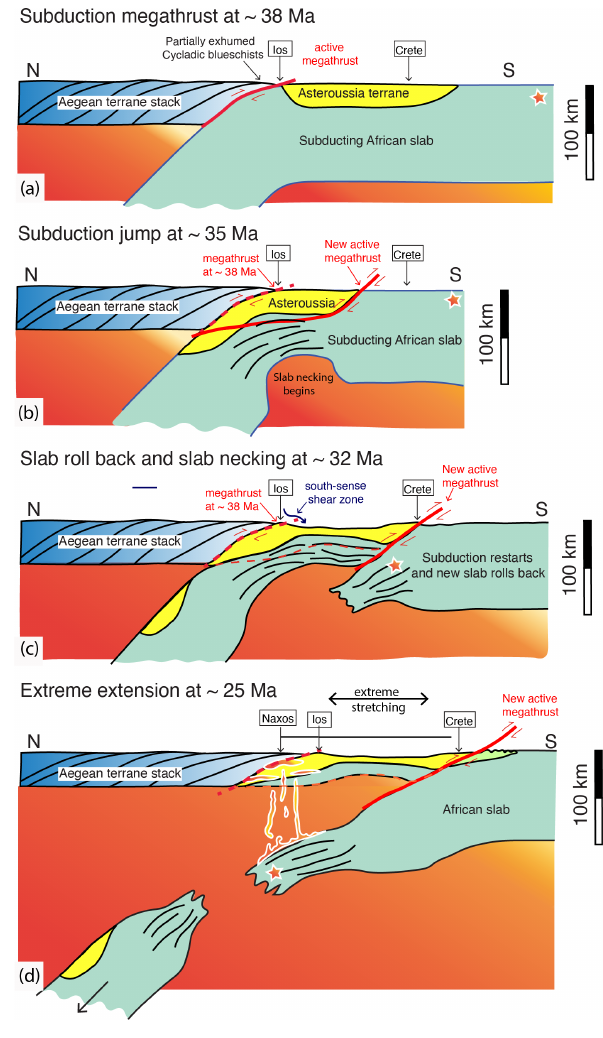
Figure 3. The slab-necking–drop-off model proposed in this paper: (a) the Asteroussia terrane arrives at the Aegean terrane stack; (b) the subduction zone jams, so the megathrust leaps southward while the African slab begins to neck and roll back; (c) by ∼ 32Ma the subduction jump is accomplished, breaking the stretching slab; (d) a new subduction zone develops in the south, with fluids rising from the slab causing melting. Rollback of the newly formed slab triggers extreme extension across the Aegean, exhuming metamorphic rocks and forming the Ios metamorphic core